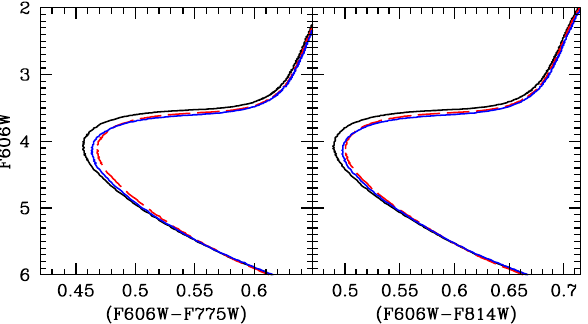
Figure 3. Left panel : as Figure 1, but for the ( F606W,F606W − F775W ) ACS@HST CMD. Right panel : as left panel, but in the ( F606W,F606W − F814W )